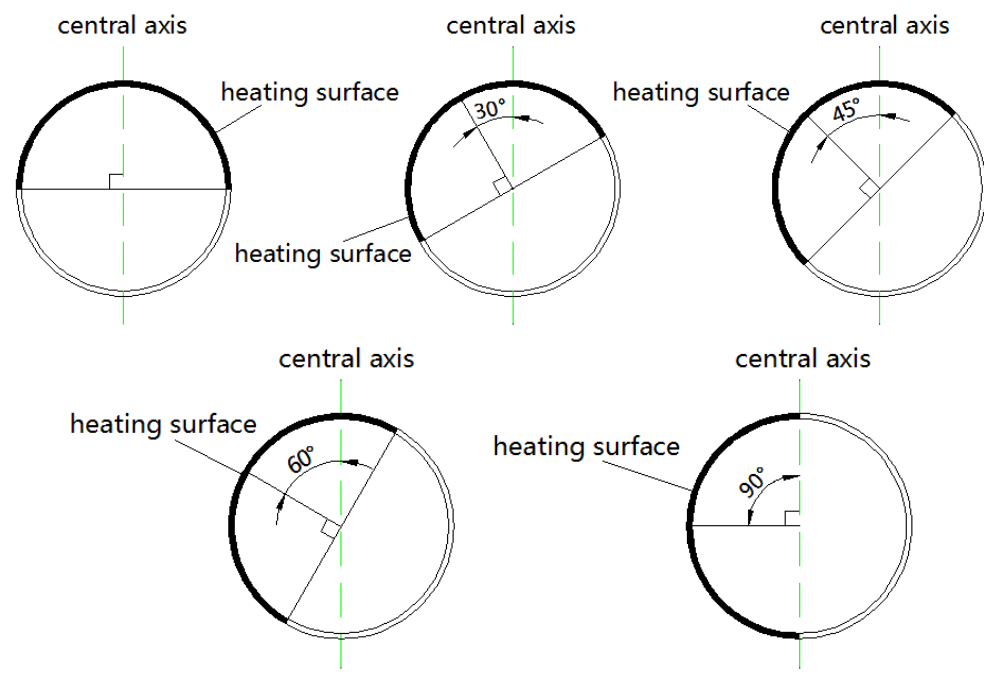
Figure 1. Different heating directions of the model.